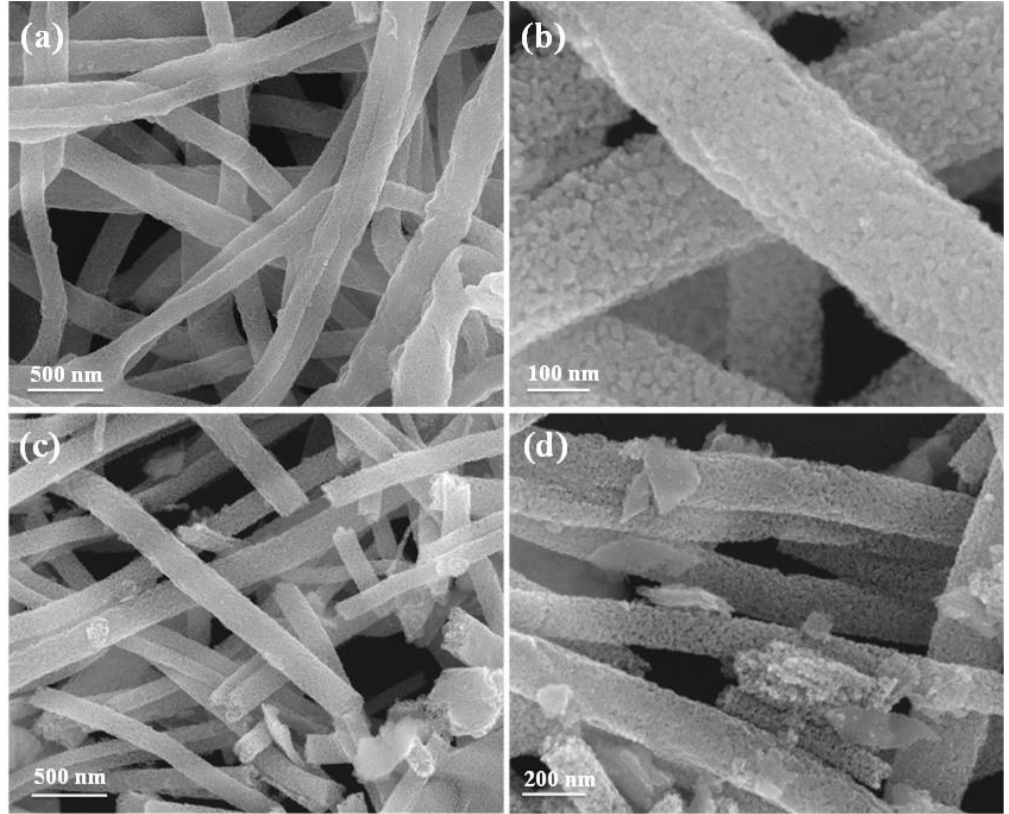
Figure 3. SEM images of ( a , b ) SnO 2 and ( c , d ) SnO 2 /CeO 2 samples.